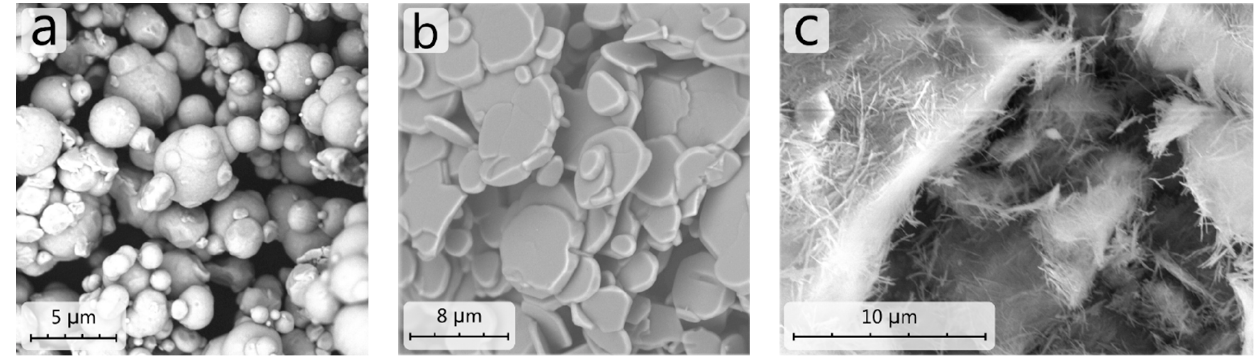
Figure 1. SEM images of iron particles ( a ), Al 2 O 3 abrasive particles ( b ), and clay mineral sepiolite ( c ). Table 1 represents the composition of MR slurry under investigation. Table 1. Composition of the MR slurry. Component Concentration